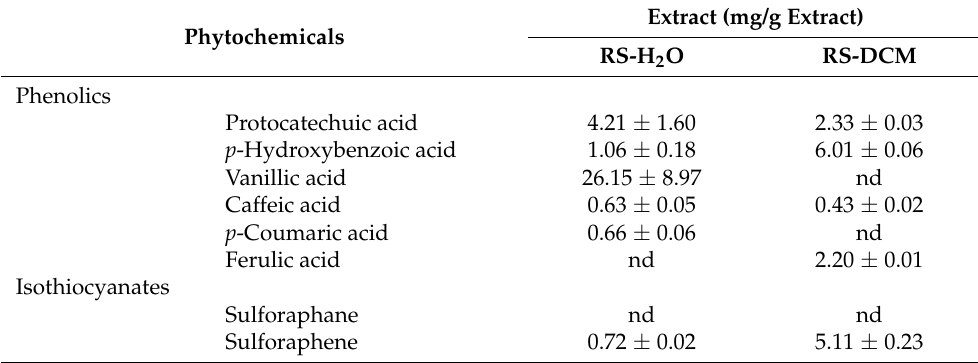
Table 2. Phytochemicals content of RS extract.